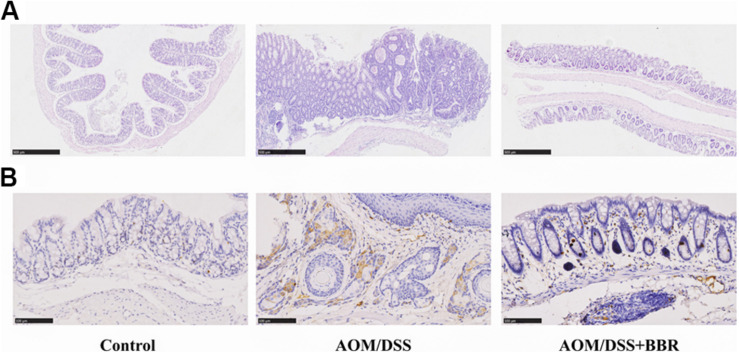
Effects of BBR on AOM/DSS induced colorectal carcinogenesis. (A) H&E staining of colorectal sections. (B) Immunohistochemistry staining of colorectal sections showing the expression of Ki-67 among groups.